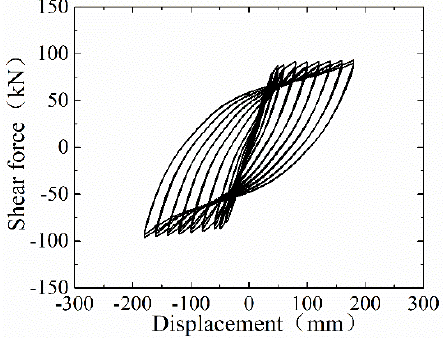
Figure 12. Crack pattern of the specimen.